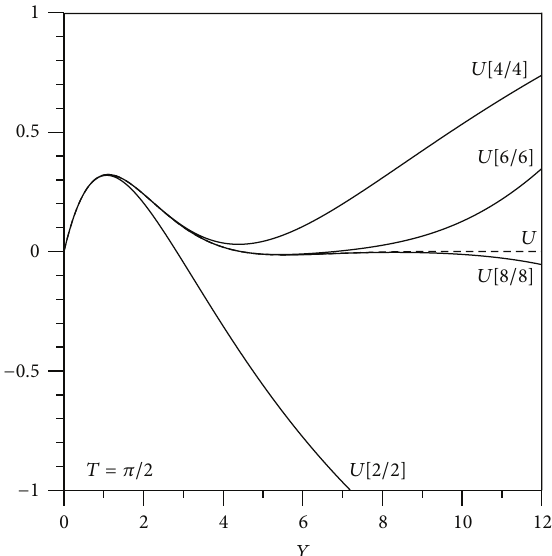
Figure 1: Comparison of Pad´e [𝑛/𝑛] solutions (solid lines) and exact solution (dash line) for Stokes’ second problem at 𝑇 = 0 .